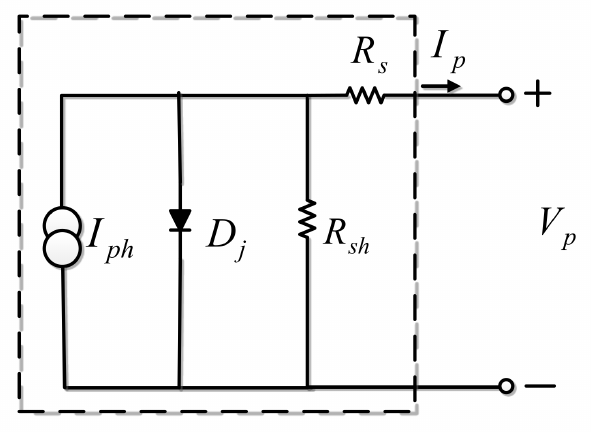
Figure 1. Equivalent circuit of a PV